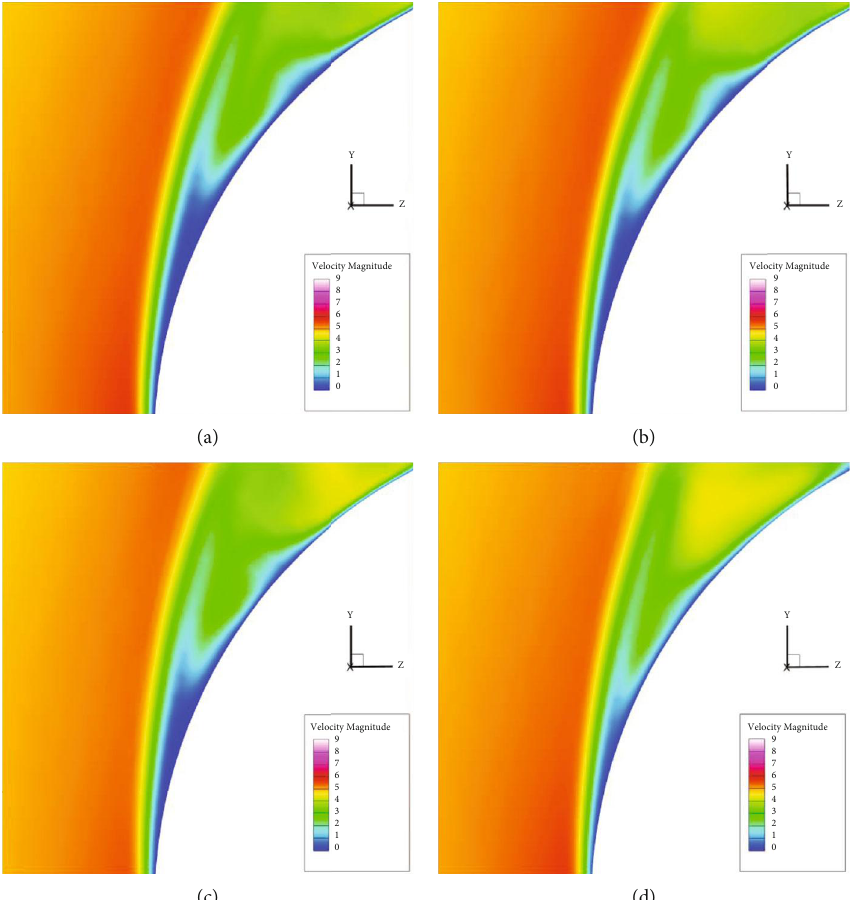
Figure 28: Comparison of closed-wall velocity with di ff erent roughness values at cross-section 3: (a) Model 1, (b) Model 2, (c) Model 3, and (d) Model